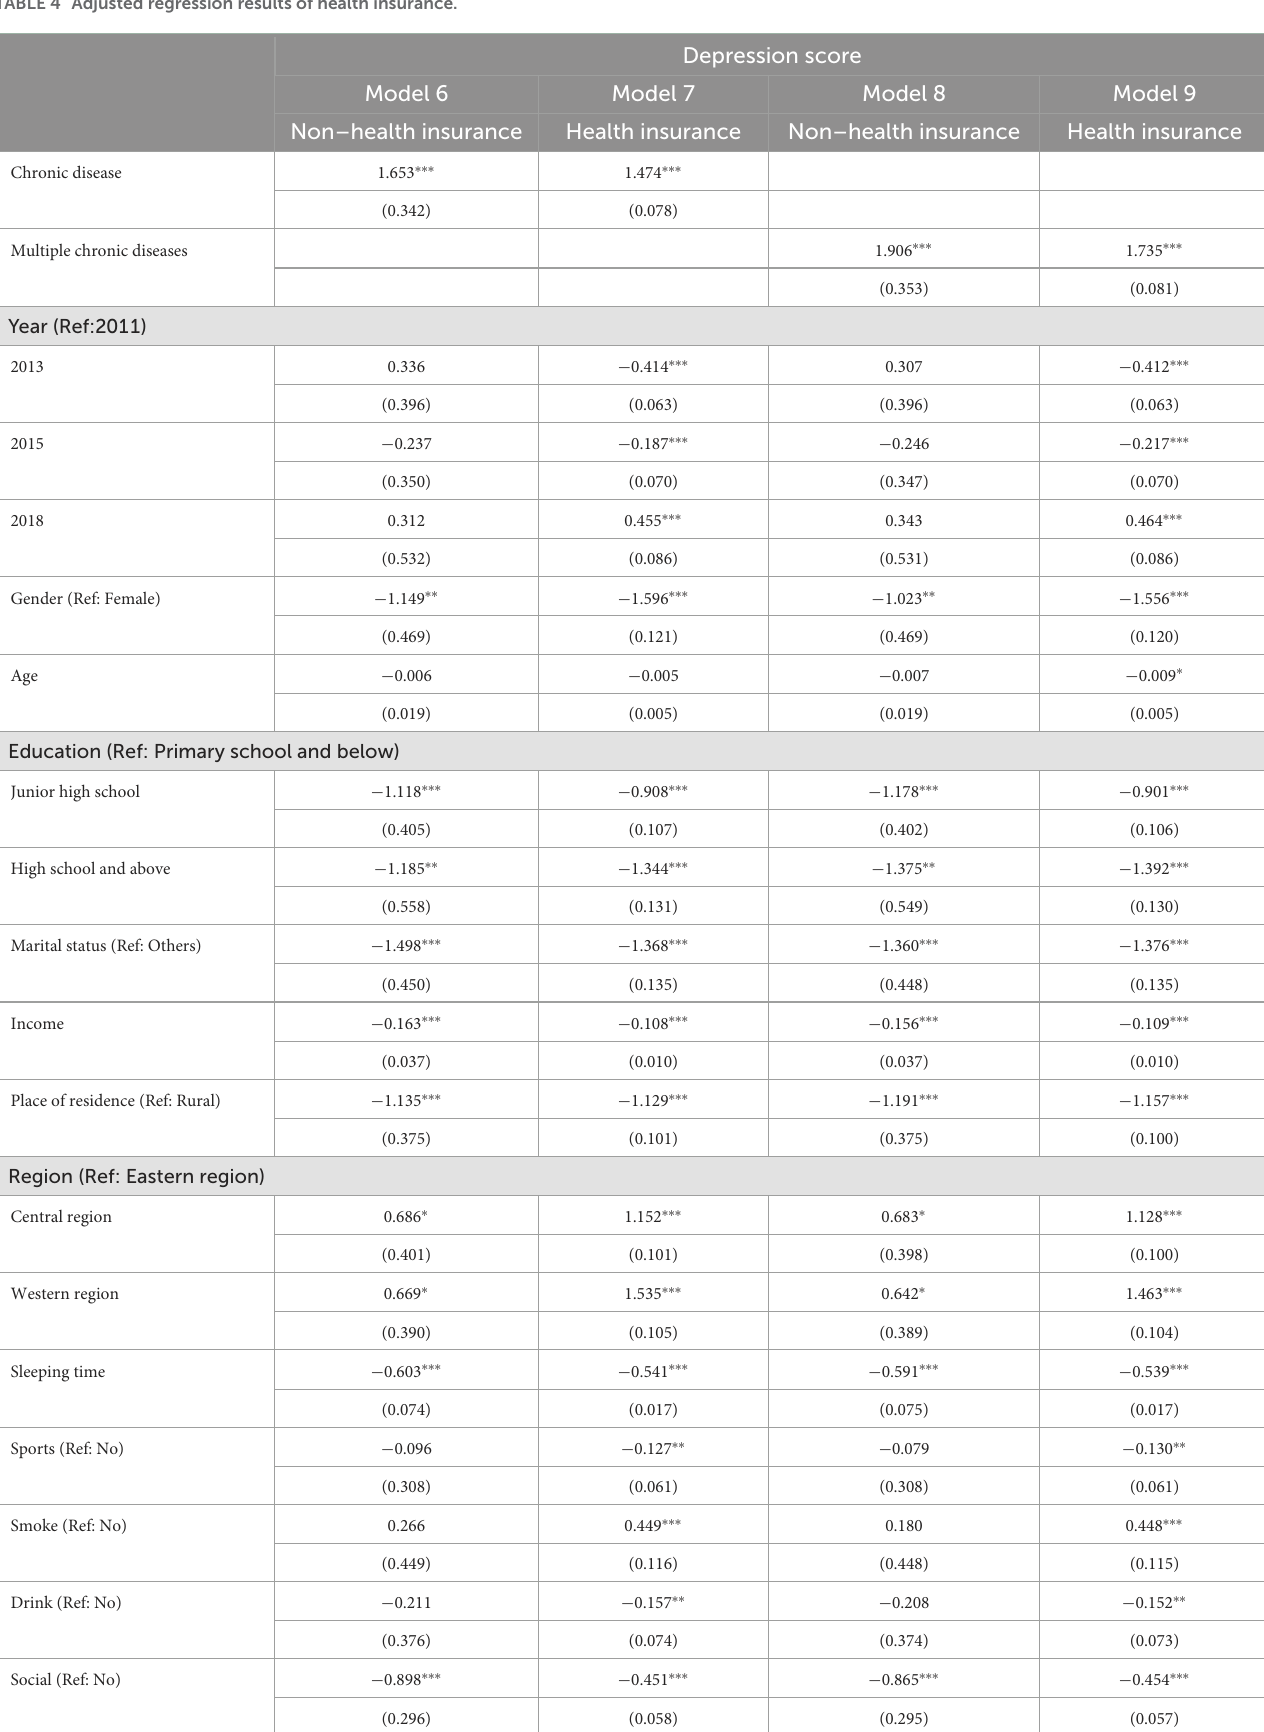
TABLE 4 Adjusted regression results of health